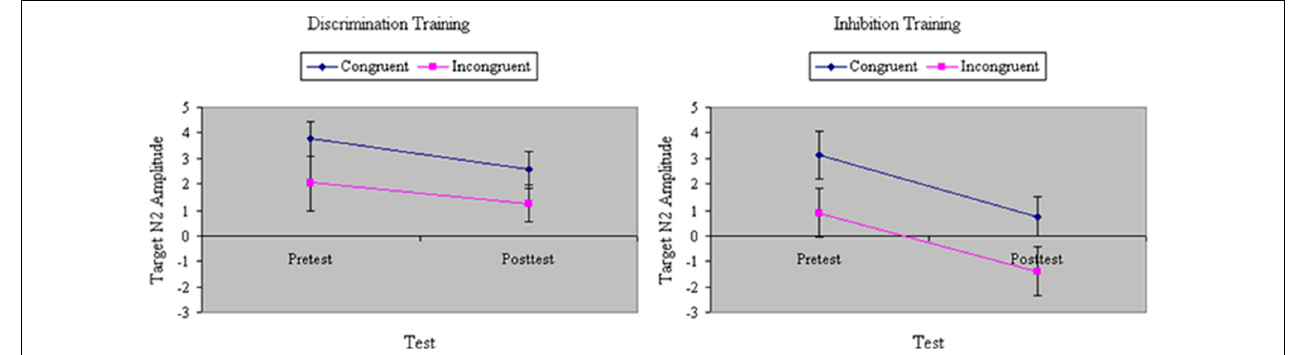
FIGURE 7 | Amplitude of N2 event-related potential (ERP) component to targets (in microvolts) on congruent and incongruent trials in the filtering task at pretest and posttest in discrimination and inhibition training groups. Enhancement from training in N2 amplitude was equivalent for congruent and incongruent stimuli.